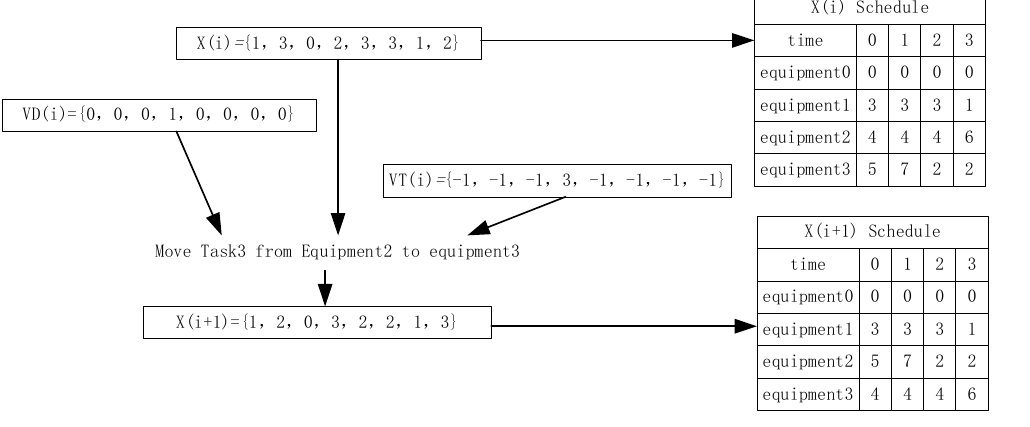
Figure 3. Example of particle motion.